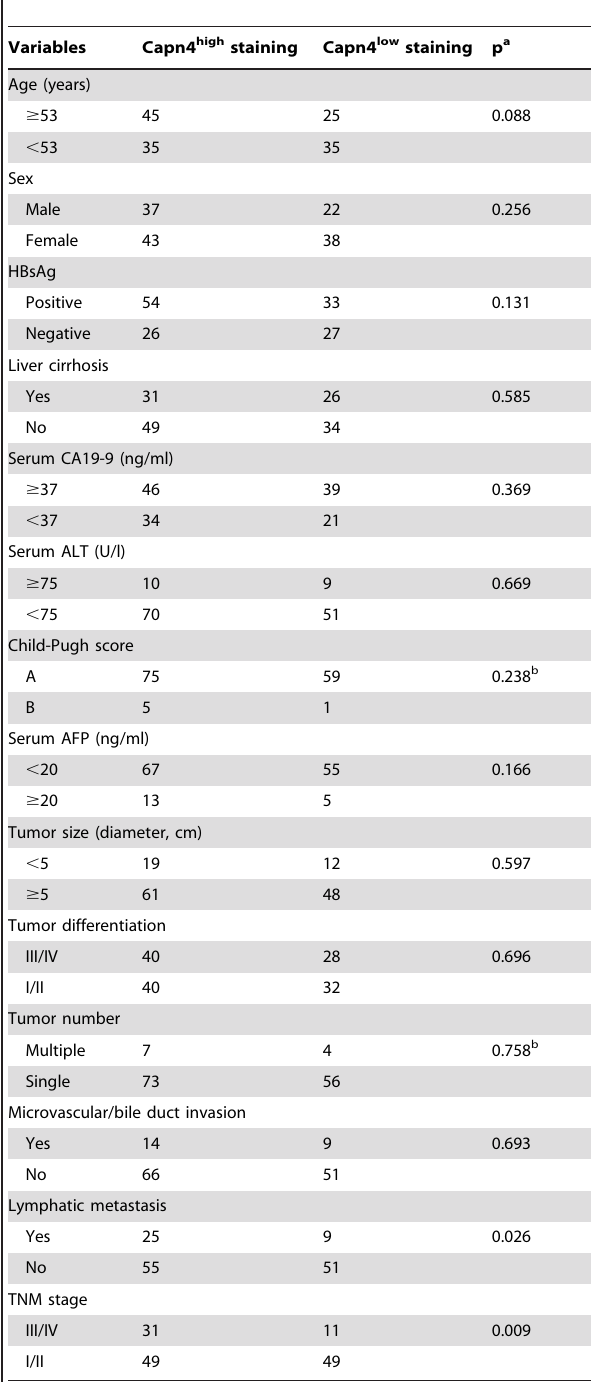
Table 1. Correlations between Capn4 and clinicopathological features in 140 ICC